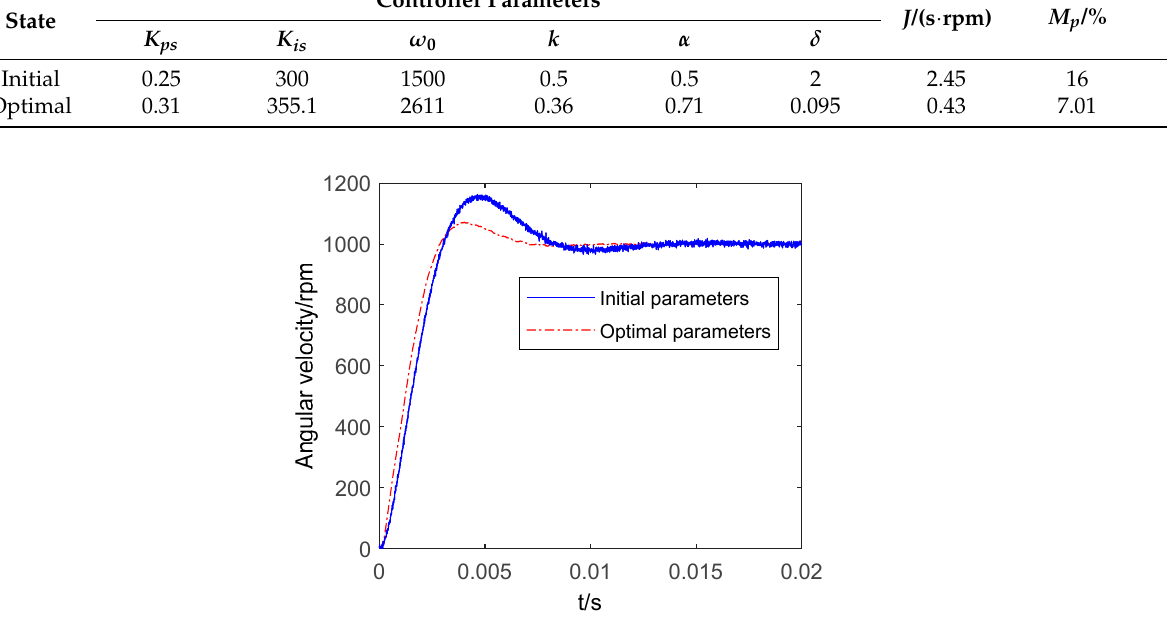
( b ) Figure 15. Response of 5sin (5 π t) ( a ) Position tracking curve; ( b ) Speed tracking curve.